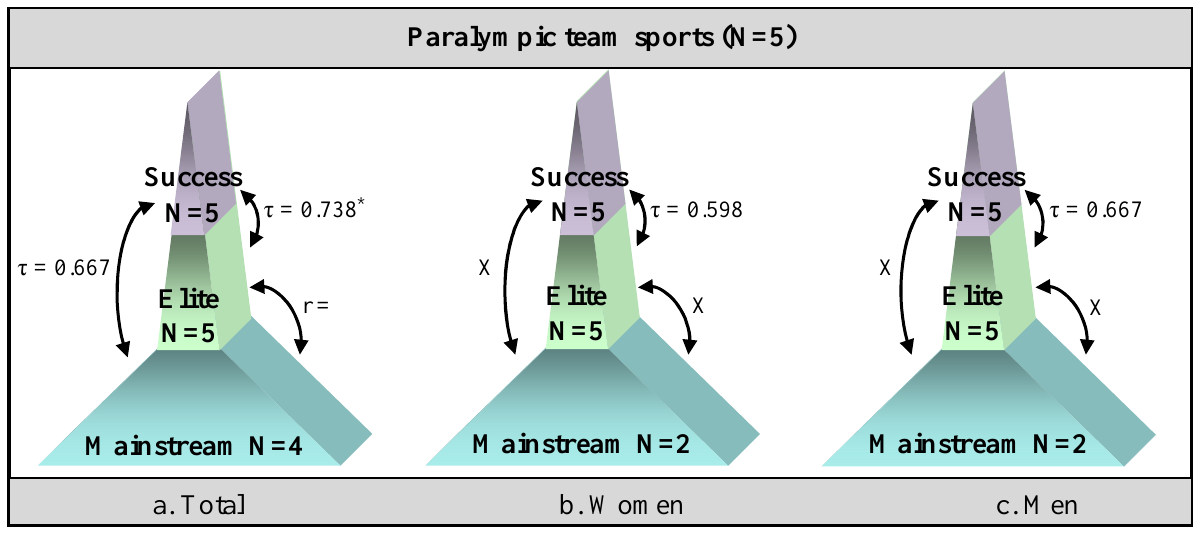
Figure 3. Correlations between mainstream- and elite participation rates and relative Paralympic success in the 5 team sports. N is the sample size, * indicates p < 0.05 and *** indicates p < 0.001. X is used when the sample size is too small to calculate Spearman’s test or Kendall’s tau. a. Relationships in all Paralympic team sports. b. Relationships for females in the Paralympic team sports. c. Relationships for males in the Paralympic team